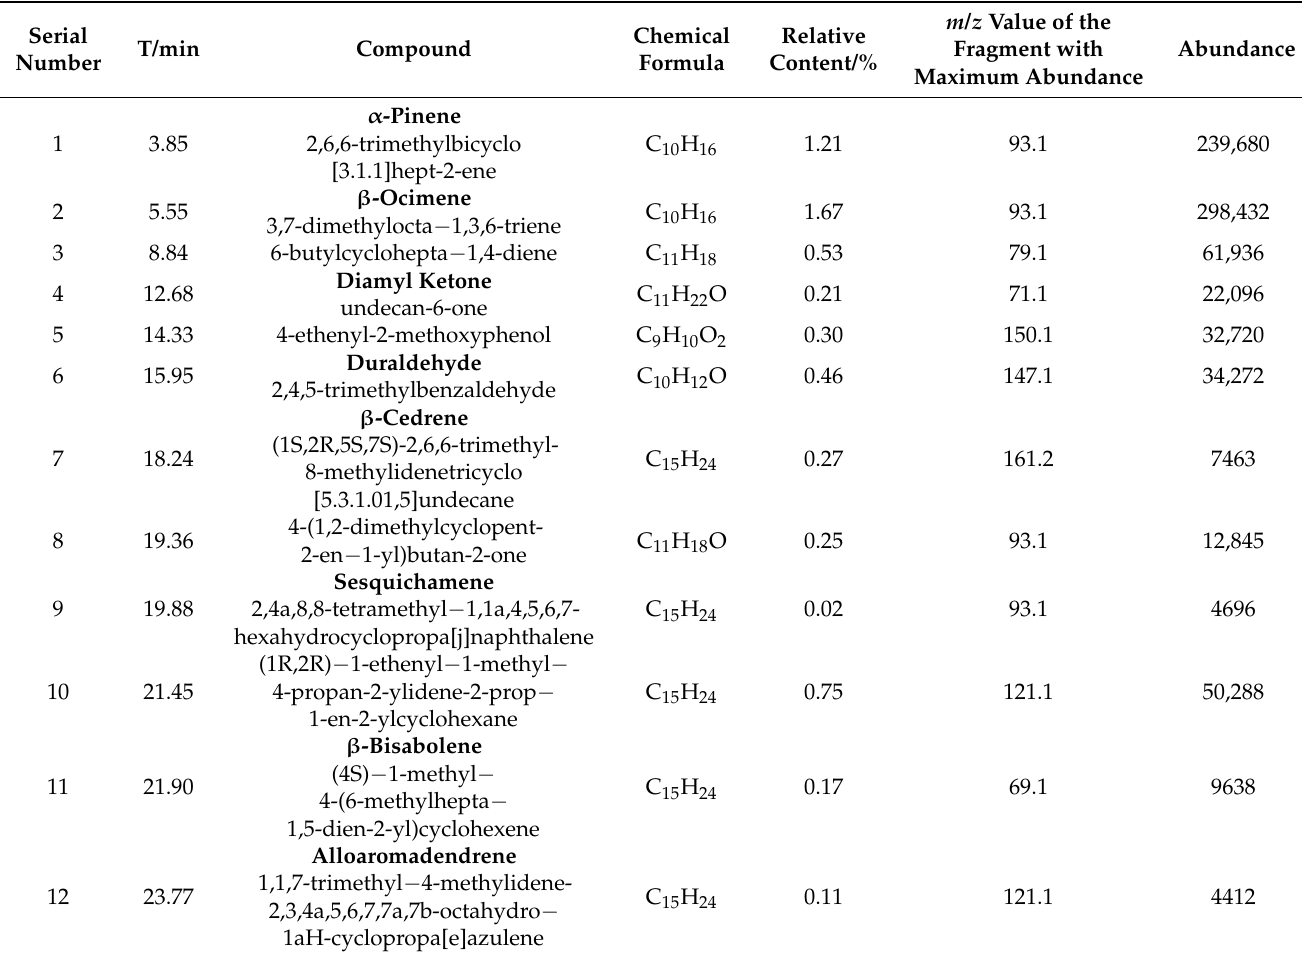
Figure 9. The total ion chromatogram of the angelica volatile oil. Table 5. The tentative identification results of the chemical composition of angelica volatile oil.